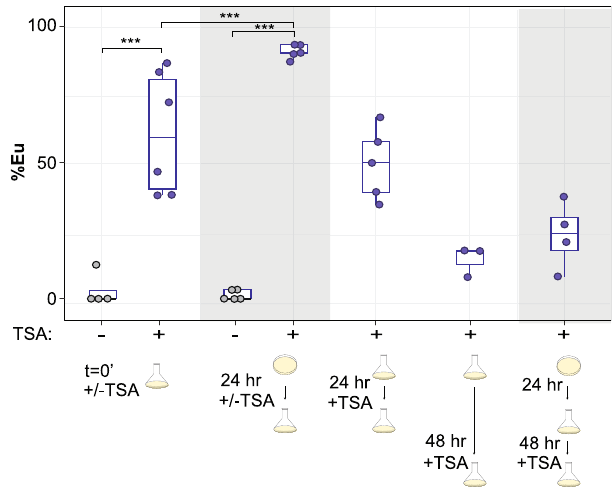
Fig. 4 | H4 acetylation can provide long term memory. Transplant experiments betweenNGM-agarand liquid culture+/-TSAatdifferent timepoints.WhenTSAis not added (-), the solvent DMSO was added. The fi rst twoexperimental conditions (DMSO and TSA) are from Fig. 2a. Individual data points are shown for all condi- tions; n =4 independent worm populations x DMSO, 6 x TSA, 5×24h switch +/-TSA, 5×24h TSA, 3×48h TSA, 4×24h switch+48h TSA. Box-plot minima and maximarepresentthe25and75%quantile,respectively,middlebarrepresents50% quantile (median). Whiskers denote 1.5x the interquartile range. Statistical sig- ni fi cance determined by binomial logistic regression on Eu and St counts. P -value forTSAvs.DMSO=8.69e-13,<2e-16forTSAvs.DMSO24hswitch,and7.67e-09for TSAvs.TSA24hswitch,* p <0.05,** p <0.01,*** p <0.001.Sourcedataareprovided as a Source Data fi